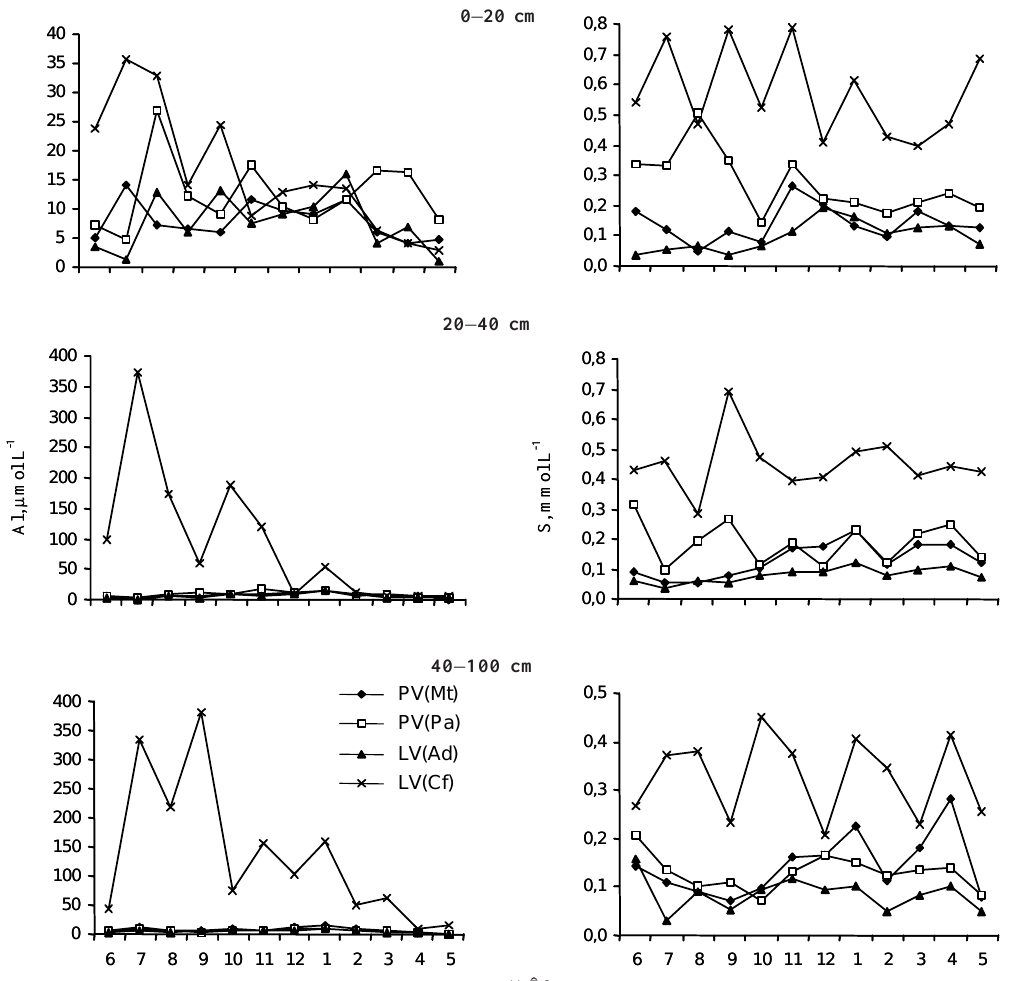
Figura 4. Variação mensal da concentração de alumínio e de enxofre na solução do Argissolo Câmbico sob mata (PVA(Mt)) e sob pastagem (PVA(Pa)) e do Latossolo Vermelho-Amarelo sem cobertura vegetal (LVA(Ad)) e sob cafeeiro (LVA(Cf)), no período de junho de 1996 a maio de 1997, em três profundidades. Média de três